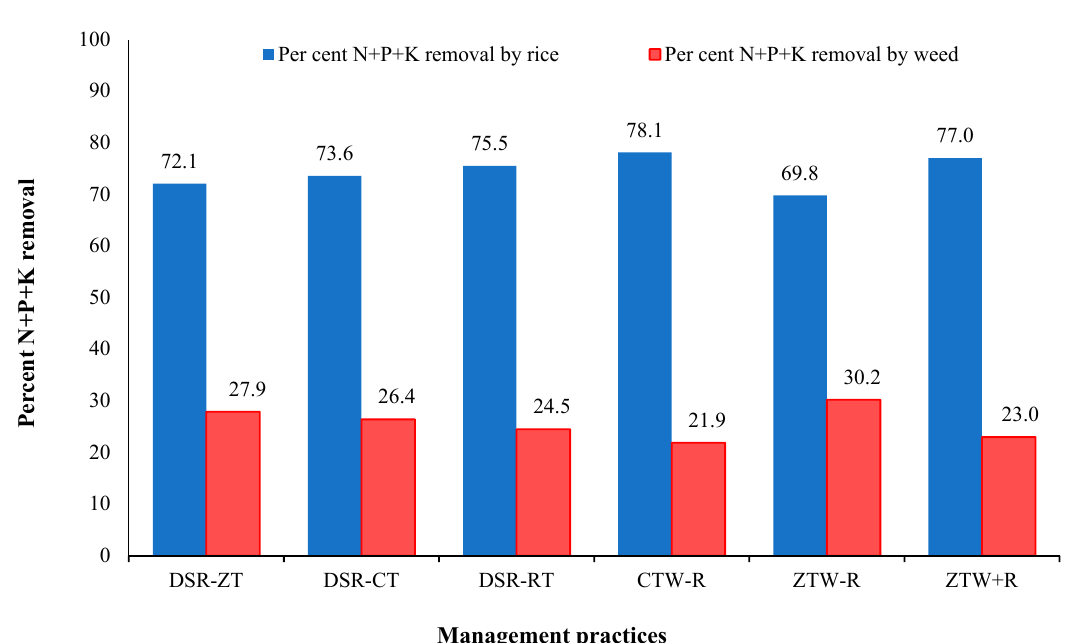
Figure 1. Percentage of macronutrients (N + P + K) removed by rice and weed under different management practices. DSR (Direct-seeded rice), CT (Conventional tillage), RT (Reduced tillage), ZT (Zero tillage), CTW (Conventional till wheat), ZTW (Zero till wheat), R (Rice residue).